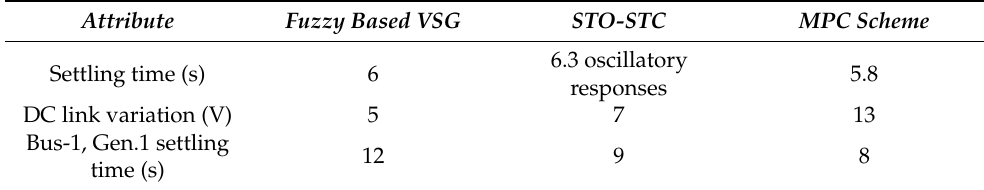
Figure 7. ( a ) Bus-12 voltage sag during fault (pu), ( b ) bus-12 frequency overshoot (Hz), ( c ) DC-link variation on fault (V), ( d ) off-shore SG power fluctuation (pu): comparison for various schemes. Table 4. Time–domain specifications on a three phase fault (bus-12).